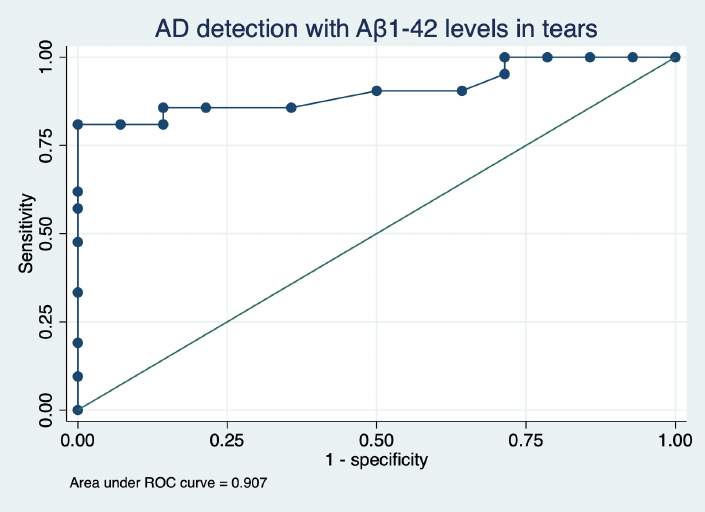
Figure 7. Receiver operating characteristic (ROC) curve generated after logistic regression with A β 1-42 levels as the independent variable and the presence of AD as the dependent variable, with the area under ROC curve (AUC) of 90.65%.